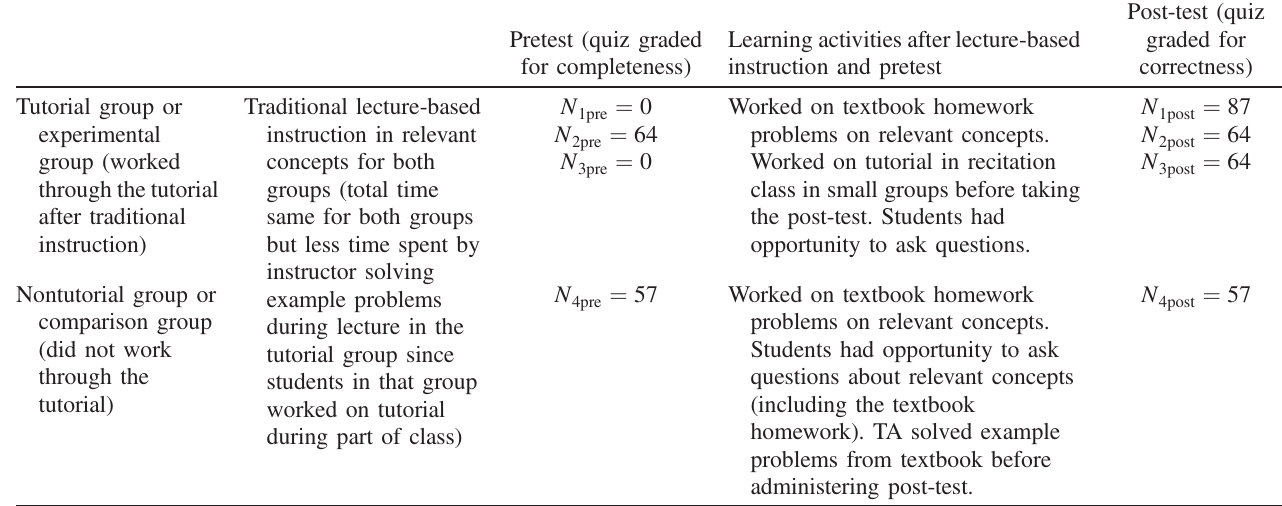
TABLE II. Summary of activities in the experimental group (tutorial group) and comparison group (nontutorial group) in different sections of the introductory physics course. For all the different sections in Table II, N 1 students who took the pretest and N 1 (only matched students who took both the pretest and post-test are included when students took both the pretest and post-test as in N 2 , N 4